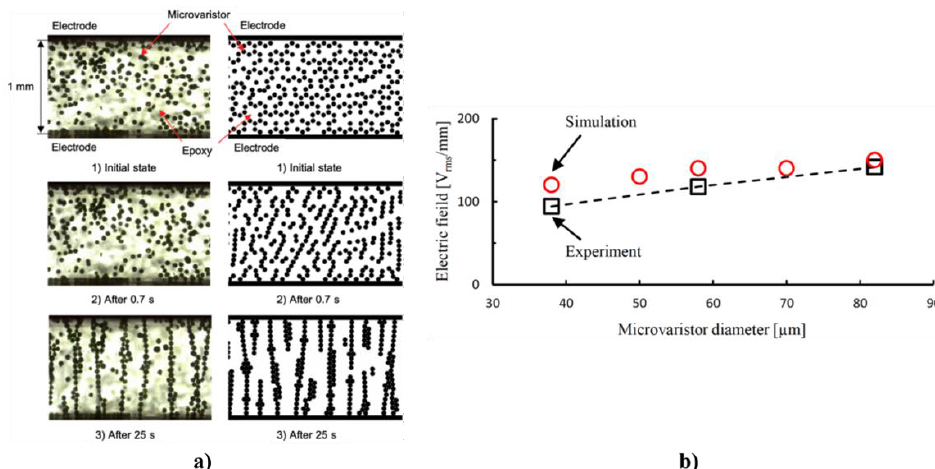
Figure 37. Comparison between experimental and simulated microvaristor deposition: ( a ) movement of fillers, ( b ) minimum electric field to form chains. © 2021 IEEE. Reprinted, with permission, from [110].